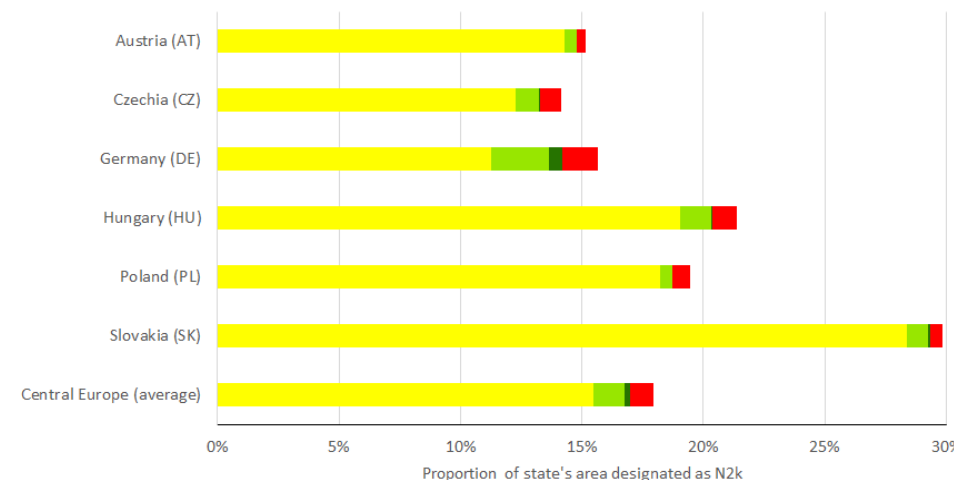
Figure 5. Proportion of national N2k network area that (i) was predefined core areas and their adjacent sites (yellow); (ii) was connected as preferentially selected land under corridors (light green); (iii) was adjacent to sites connected by the corridors (dark green); (iv) remained disconnected by GI (red).